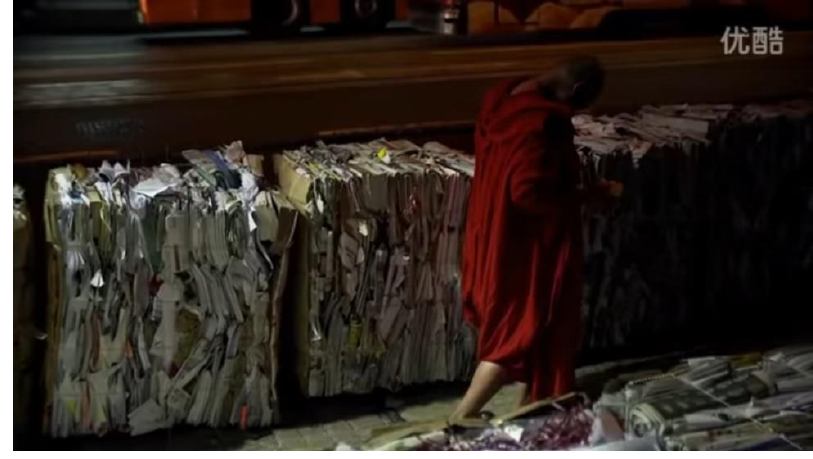
Figure 1. A homeless wanderer.